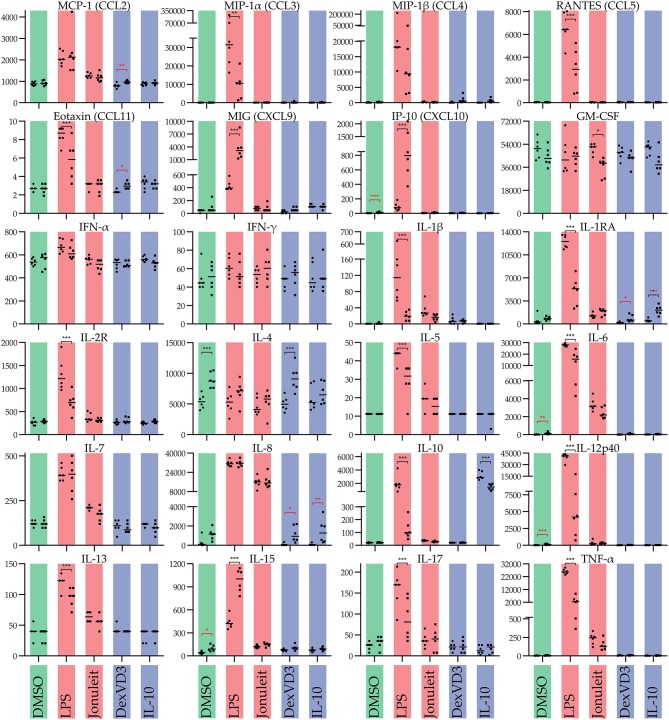
Influence of the culture dish on the cytokine production of differentially stimulated moDC. Cytokines were measured in cell free culture supernatants of the generated moDC populations. Color code: Control (DMSO)—green, immunogenic DC populations (LPS and Jonuleit cytokine cocktail, respectively)—red, tolerogenic DC populations (Dexamethasone with vitamin D3 and IL-10, respectively)—blue. Circles (left): standard culture dish; squares (right): non-adherent culture dish. The median is marked with a line. Significance values are given in grades *P < 0.05, **P < 0.01, and ***P < 0.001. Black significance grades are the result of a collective 2 way ANOVA testing for all treatments, red grades are from separate tests for the iDC/tolDC and immunogen subgroups (n = 6).